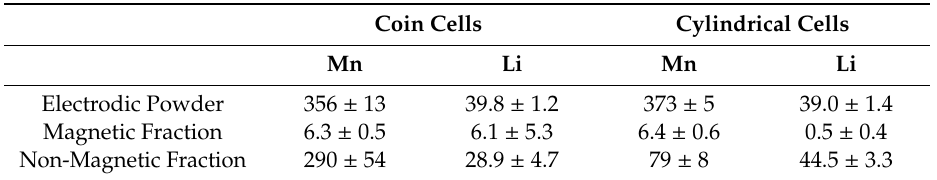
Table 3. Metal composition ([mg g − 1 ]) of solid fractions separated from coin cells and cylindrical cells treated in the LIBAT prototype for cryo-crushing and separation.